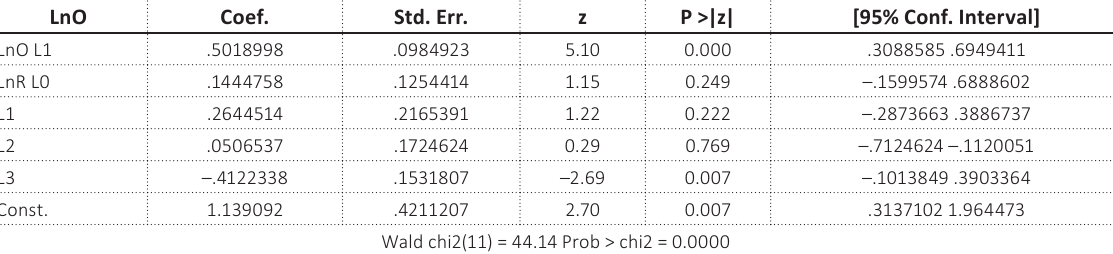
Source: Authors’ elaboration in the STATA software